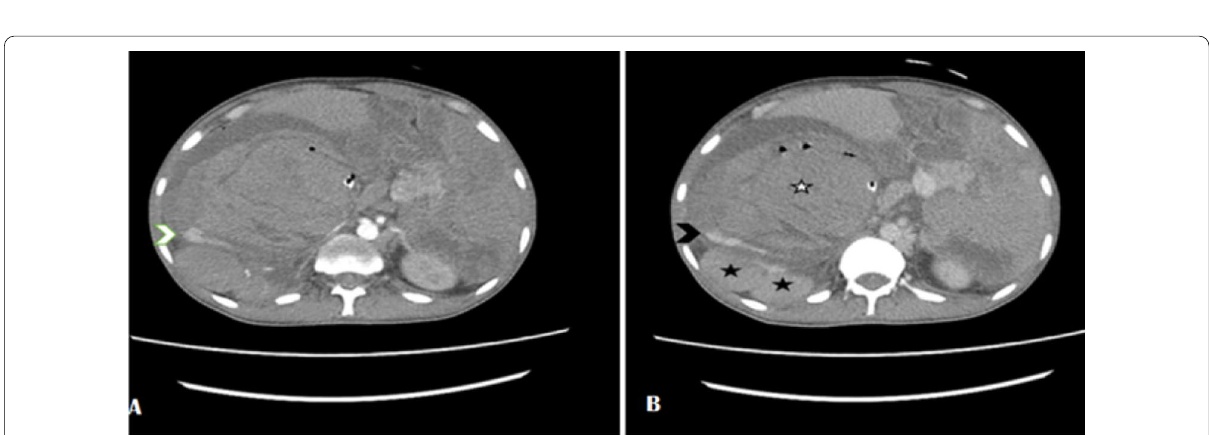
Fig. 2 Contrast-enhanced CT (CECT) to identify any area of active bleeding. A Axial section of CECT arterial phase, showing a liner hyperdensity along gastro-splenic ligament (white arrowhead). B Axial section from CECT portal venous phase showing increasing linear hyperdensity along gastro-splenic ligament (black arrowhead) representing active bleeding. The stomach is significantly distended with high-density content representing blood clots (white asterisk). Two small-sized splenules are seen (black asterisks) instead of one parent spleen representing polysplenia which is an additional feature of heterotaxy syndrome with left